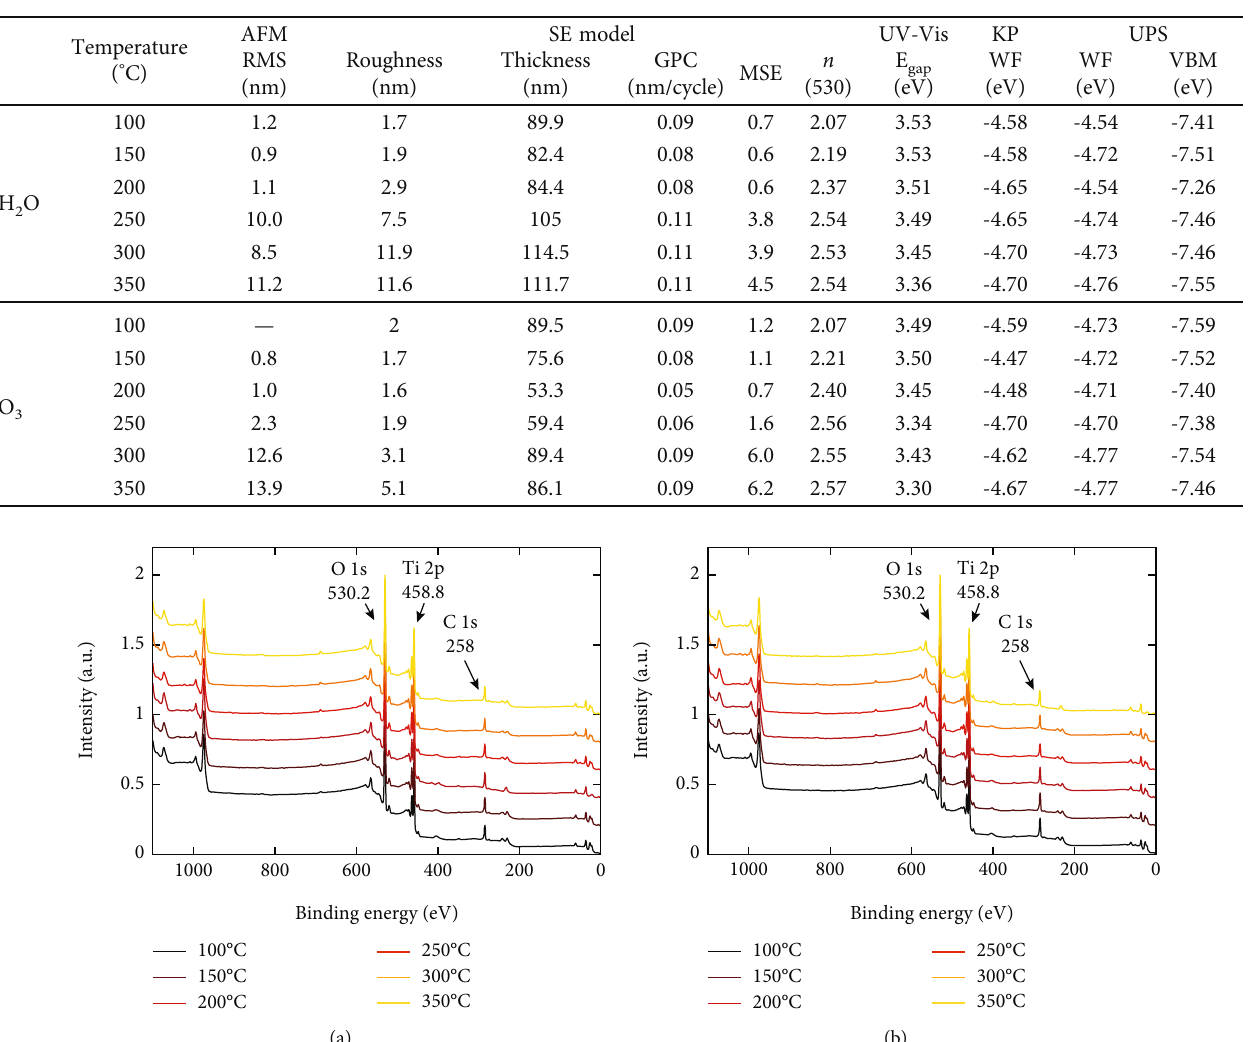
Figure 1: XPS overview scans of TiO